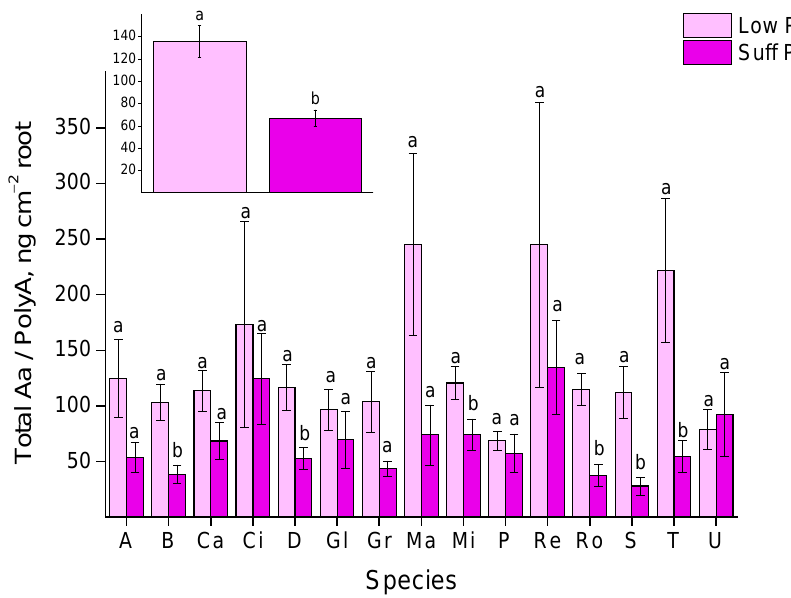
Figure 6. Total amino acid and polyamines (Aa/PolyA) exuded by the roots of fifteen eucalypt species grown under low (Low P, clear color) and sufficient (Suff P, dark color) phosphorus concentrations. Different letters indicate significant differences between low and sufficient P concentrations within each species by the Tukey test ( p < 0.05). Species abbreviations: A— E. acmenoides , B— E.